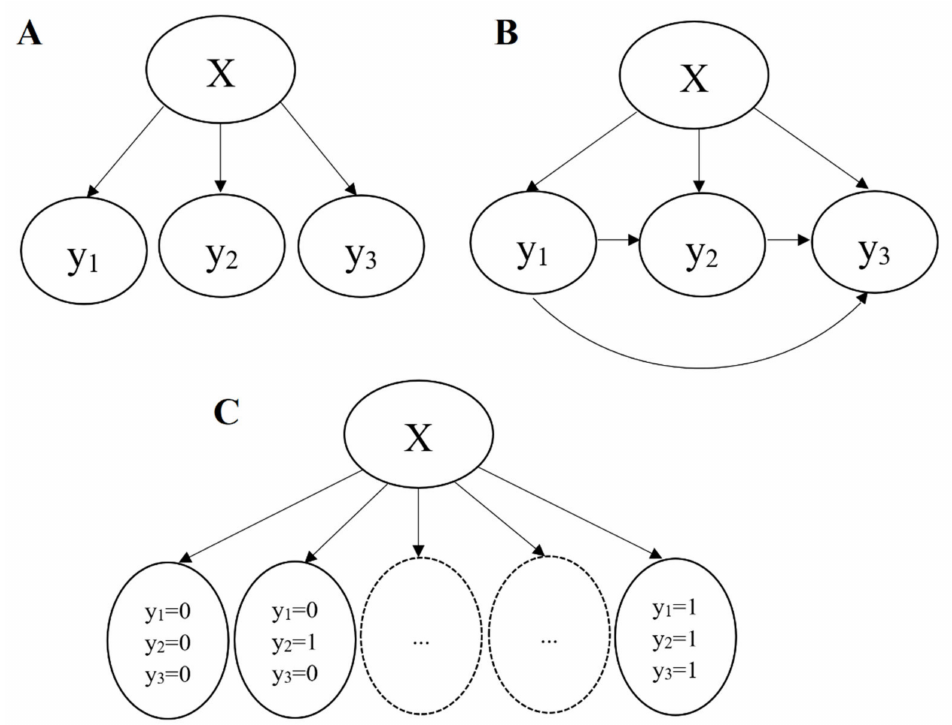
Figure 1. Transformation methods of multilabel classification problems, X represents the data features, y i represents the calculation results for the i th label. ( A ) Binary relevance (BR) transforms the multilabel data with 3 labels into 3 independent binary datasets. ( B ) The transformation of the multilabel dataset by classifier chains CC. ( C ) The process of label power set (LP) for multilabel